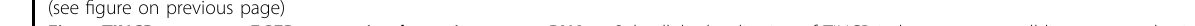
Fig. 5 TINCR promotes EGFR expression by acting as a ceRNA. a Subcellular localization of TINCR in breast-cancer cell lines, assessed using nuclear/cytoplasmic extract isolation assay. b Overlapping miRNAs in transcriptome miRNA sequencing data from HMUCC cohort and TargetScan, RNA22, and starBase databases. Venn diagrams were generated using Venny online software (http://bioinfogp.cnb.csic.es/tools/ venny/). c qRT-PCR examination of the expression of miRNAs in UACC 812 cells transfected with a TINCR-speci fi c siRNA or scrambled siRNA. d , e Expression of TINCR, EGFR mRNA ( d ), and EGFR protein ( e ) in UACC 812 and MDA-MB-231 cells treated with miR-503-5p mimic or inhibitor. f , g Complementarity between miR-503-5p seed sequence and 3 ʹ -UTRs of TINCR ( f ) and EGFR ( g ) predicted through a computational and bioinformatics-based approach by using TargetScan and StarBase online databases. Watson – Crick complementarity is connected by “ |. ” Nucleotide-replacement mutations made to the genes are underlined. h , i Luciferase-reporter assay for assessing interactions between miR-503-5p and its binding sites or mutated binding sites in 3 ʹ -UTRs of TINCR ( h ) and EGFR ( i ) in HEK293T cells. Data are presented as means from three independent experiments ± S.D. * P < 0.05, ** P < 0.01, *** P < 0.001, **** P <